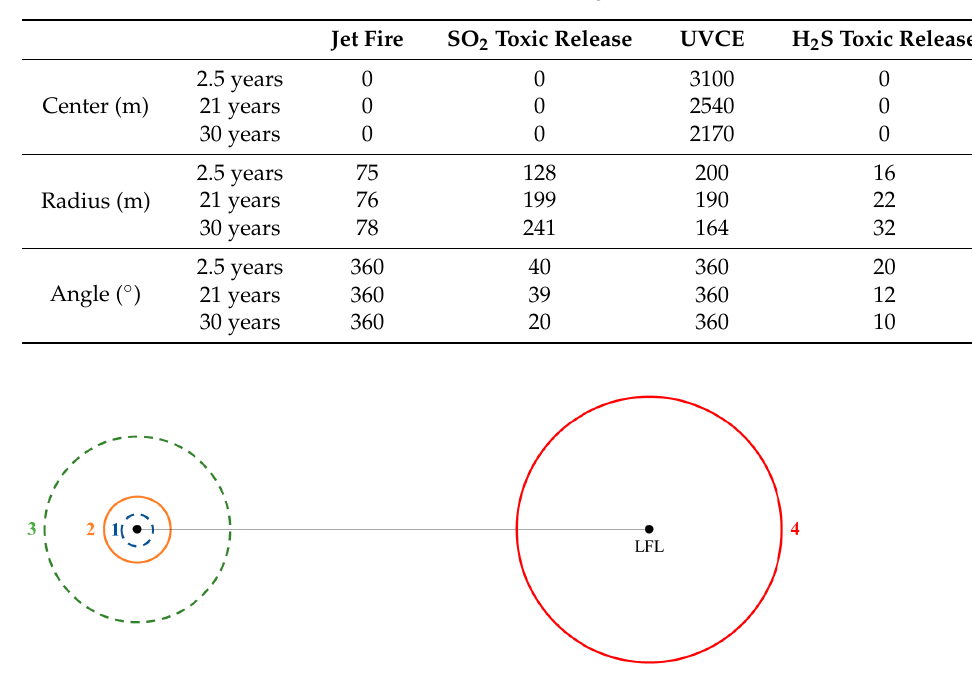
Table 10. Effect zone characteristics (center, radius and angle) for each incident outcome and time.